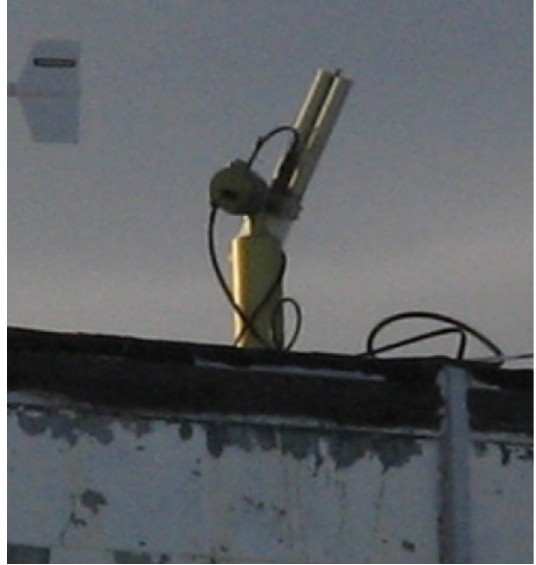
Figure 5. The Cimel installed on the roof of building